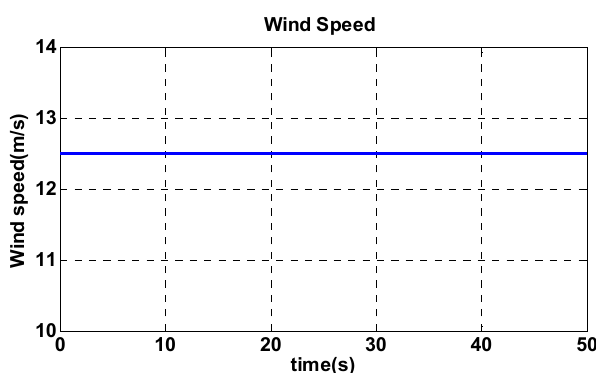
Figure 13. Step input constant wind speed 12